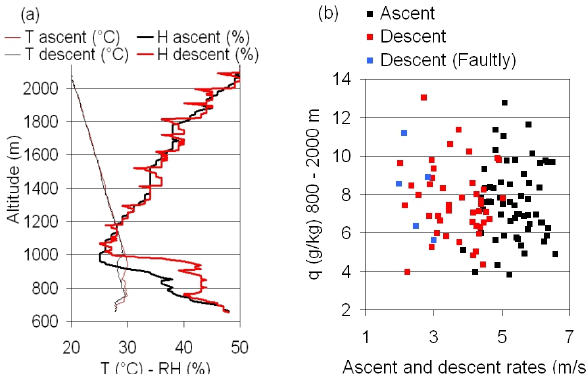
Fig. 8. Effect of insufficient ventilation on radiosonde measure- ments. (a) Example of disturbed sounding made during BLLAST on 26 June 2012, at 20:08UTC. (b) Ascent and descent rates vs. mean specific humidity (gkg − 1 ) between 800 and 2000m for ascending soundings (black), descending soundings (red) and disturbed de- scending soundings